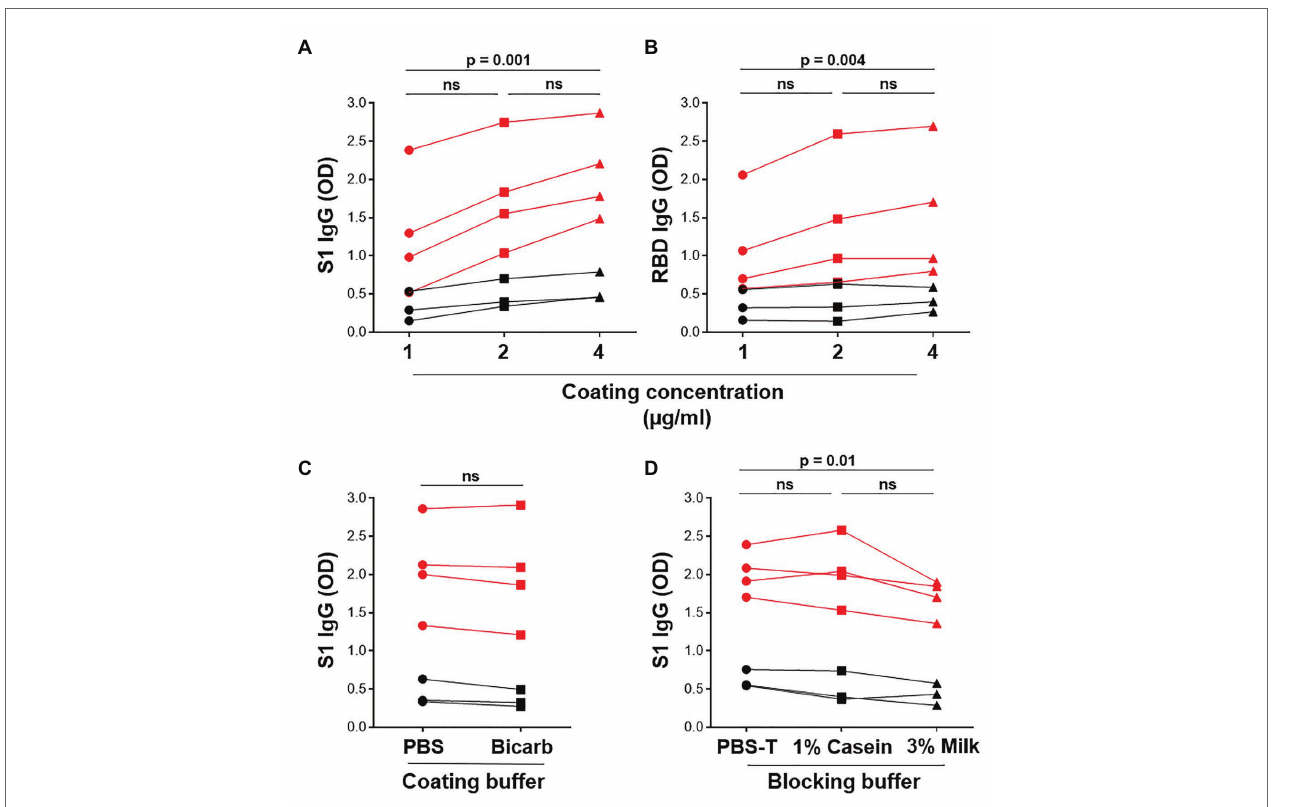
FIGURE 2 | Optimization of ELISA antigen coating concentration, coating buffer, and blocking buffer. The effect of antigen coating concentration (1, 2, and 4 μ g/ml) was tested for (A) S1 and (B) RBD, using serum samples from SARS-CoV-2 positive convalescent participants ( n = 7). Statistical analyses were performed using the Friedman test with Dunn’s test for multiple comparisons. (C) Comparison of phosphate buffered saline (PBS) and bicarbonate buffer for coating viral antigens. Statistical analyses were performed using a Wilcoxon matched pair’s test. (D) The effect of different blocking solutions. Statistical analysis was performed using the Friedman test with Dunn’s test for multiple